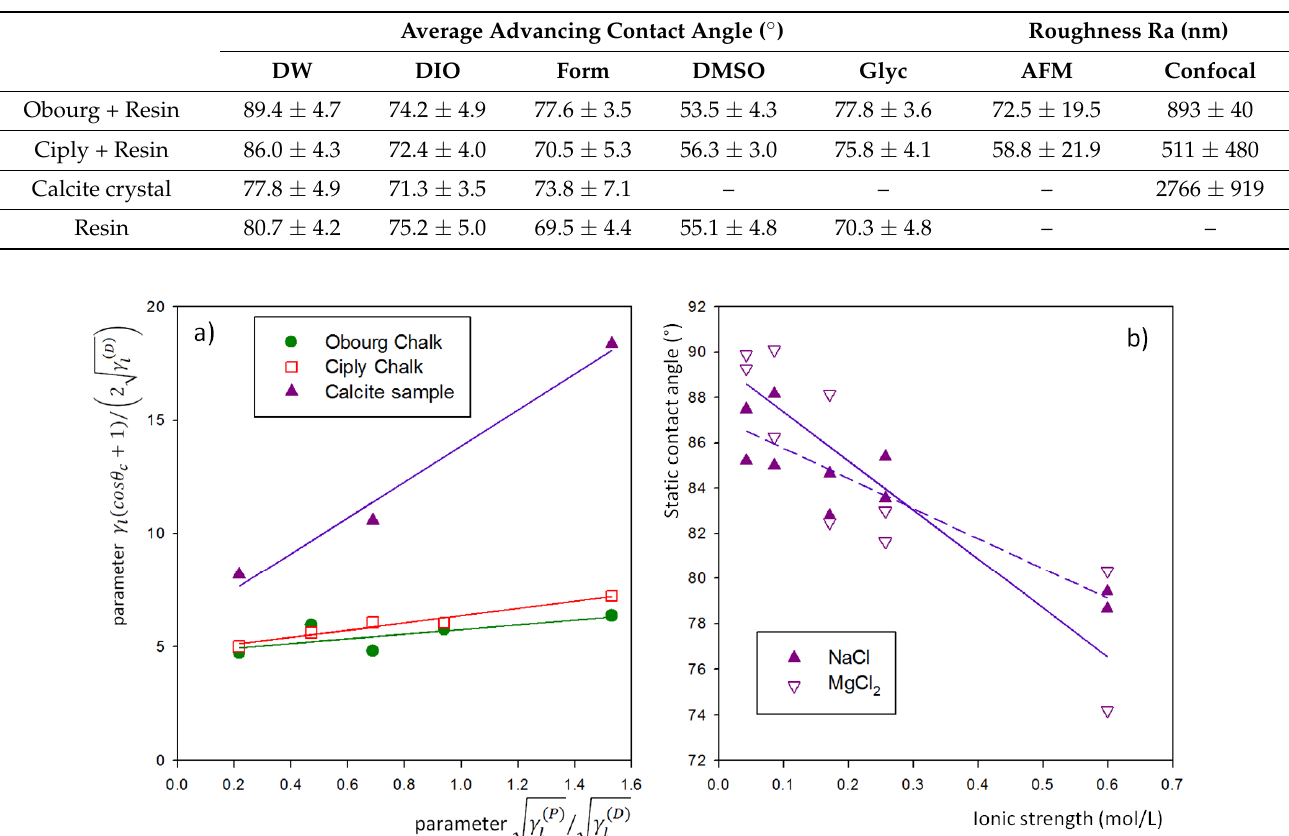
Table 6. Average advancing contact angle of different model fluids on the different studied surfaces (see caption of Table 2 for fluid nomenclature) and surface roughness measured by AFM and laser confocal microscopy. For calcite crystal only three fluids were tested.